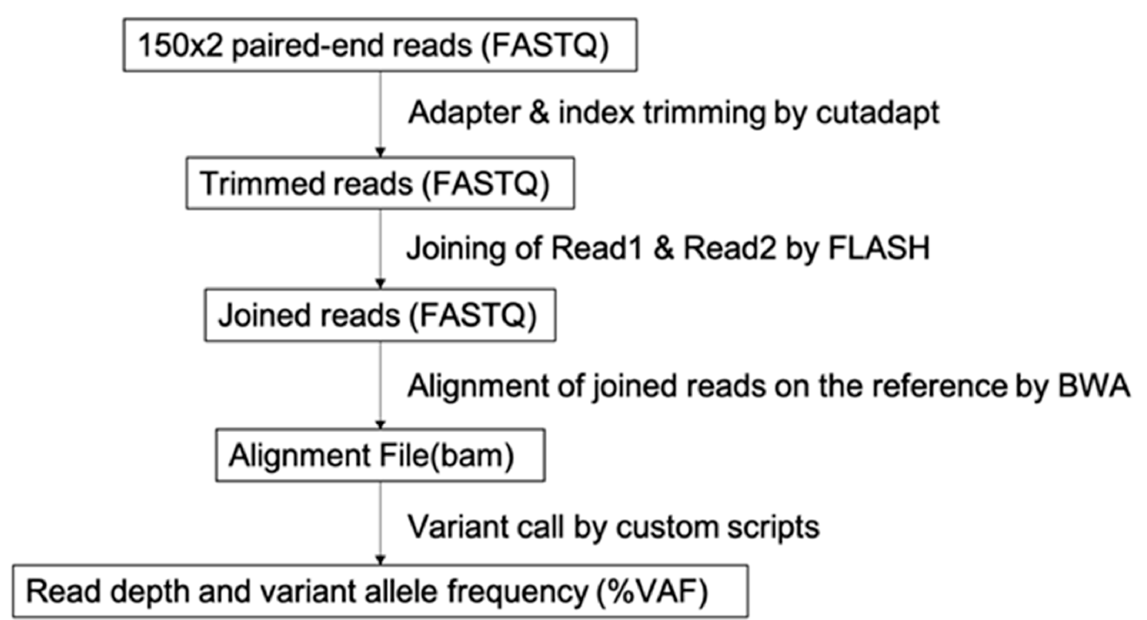
Figure 1. Flowchart of bioinformatics pipeline.